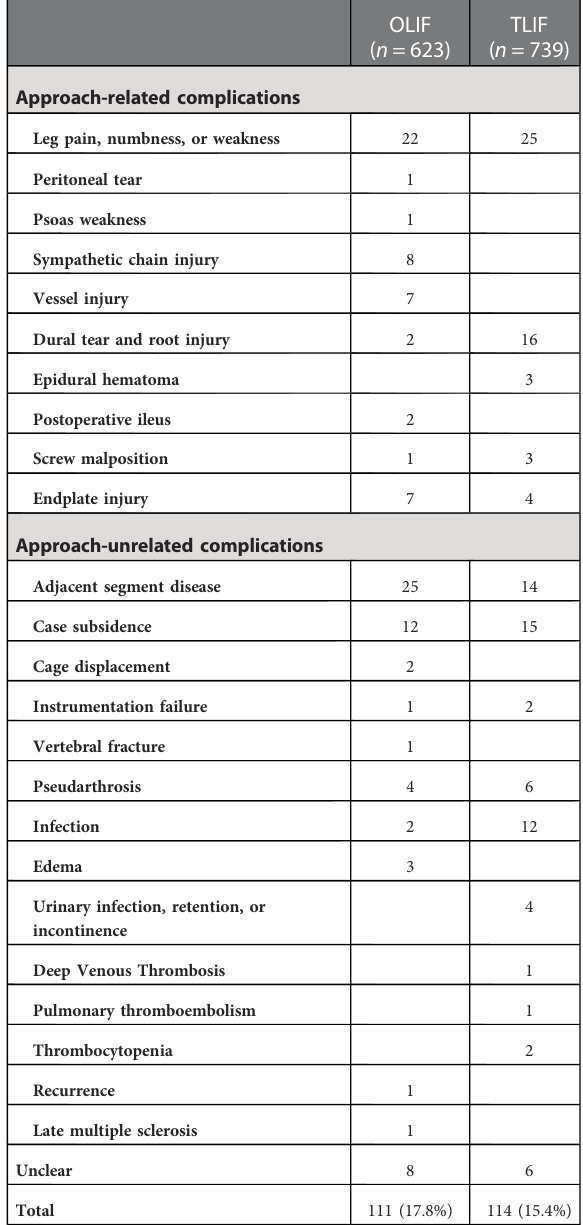
TABLE 3 Complications comparison between OLIF and